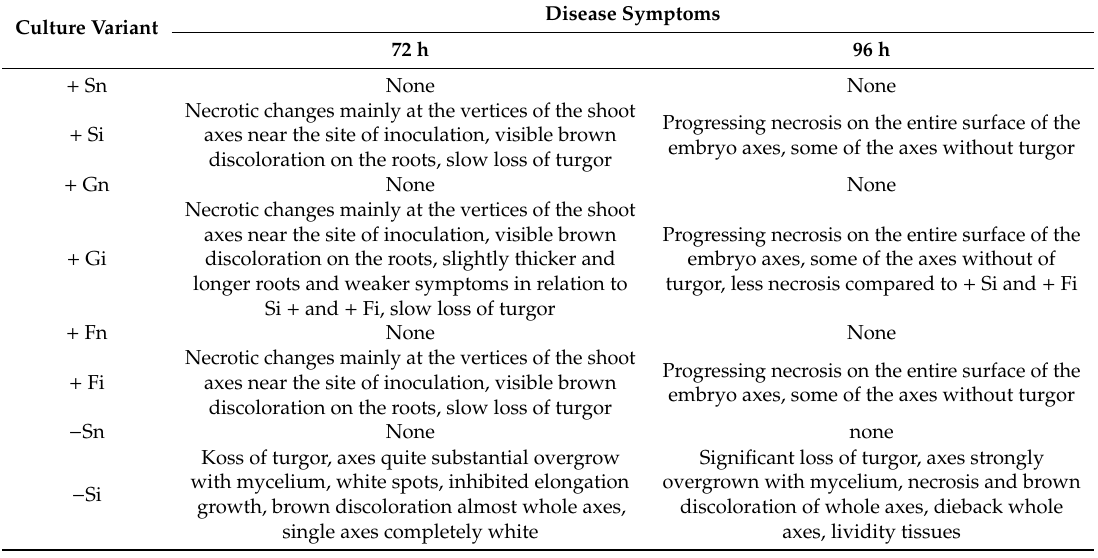
Table 1. Disease symptoms of yellow lupine noninoculated embryo axes (n) or inoculated (i) with Fusarium oxysporum f. sp. lupini and cultured in vitro on Heller’s medium with sucrose ( + S), glucose ( + G), fructose ( + F) or without it ( −